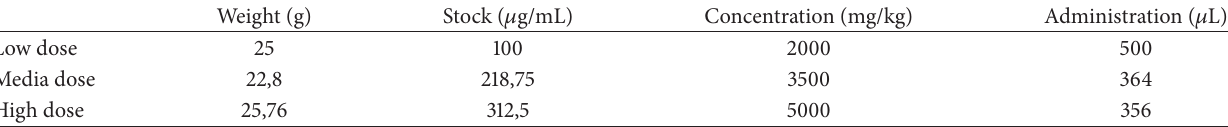
Table 1: Illustration of ceria NPs administration scheme in the acute toxicity